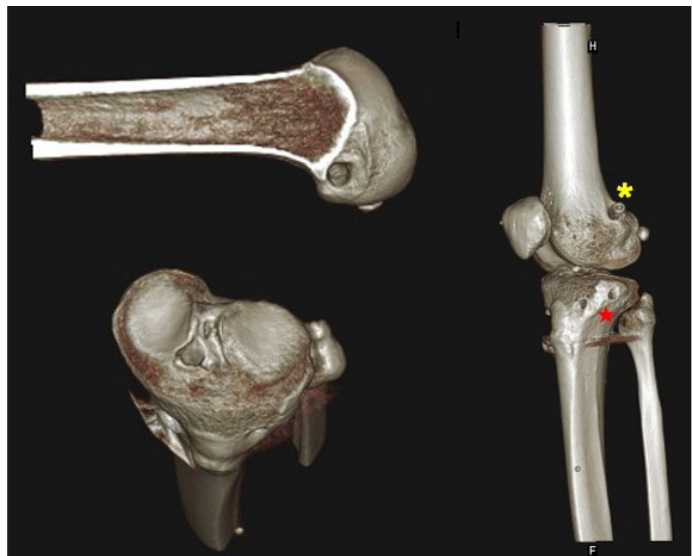
Figure 3. One patient with follow-up computed tomography imaging who received surgery using our technique of combined ACL and ALL reconstruction. The side-to-side laxity under 134 N with the GNRB arthrometer was 0.1 mm for this patient. (Asterisk: the anatomic femoral tunnel of ALL located at the lateral epicondyle posteriorly and proximally. Star: the anatomic tibial tunnel of ALL located between the Gerdy’s tubercle and the fibular head.)